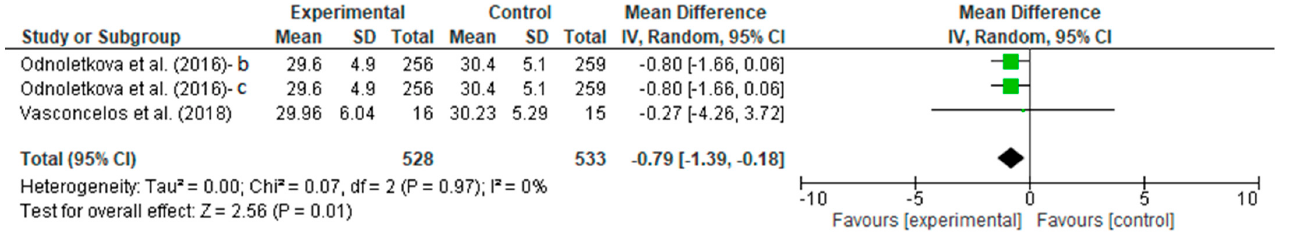
Figure 14. Forest plot intervention vs. control of telecoaching in achieving a BMI outcome [15,21,22].